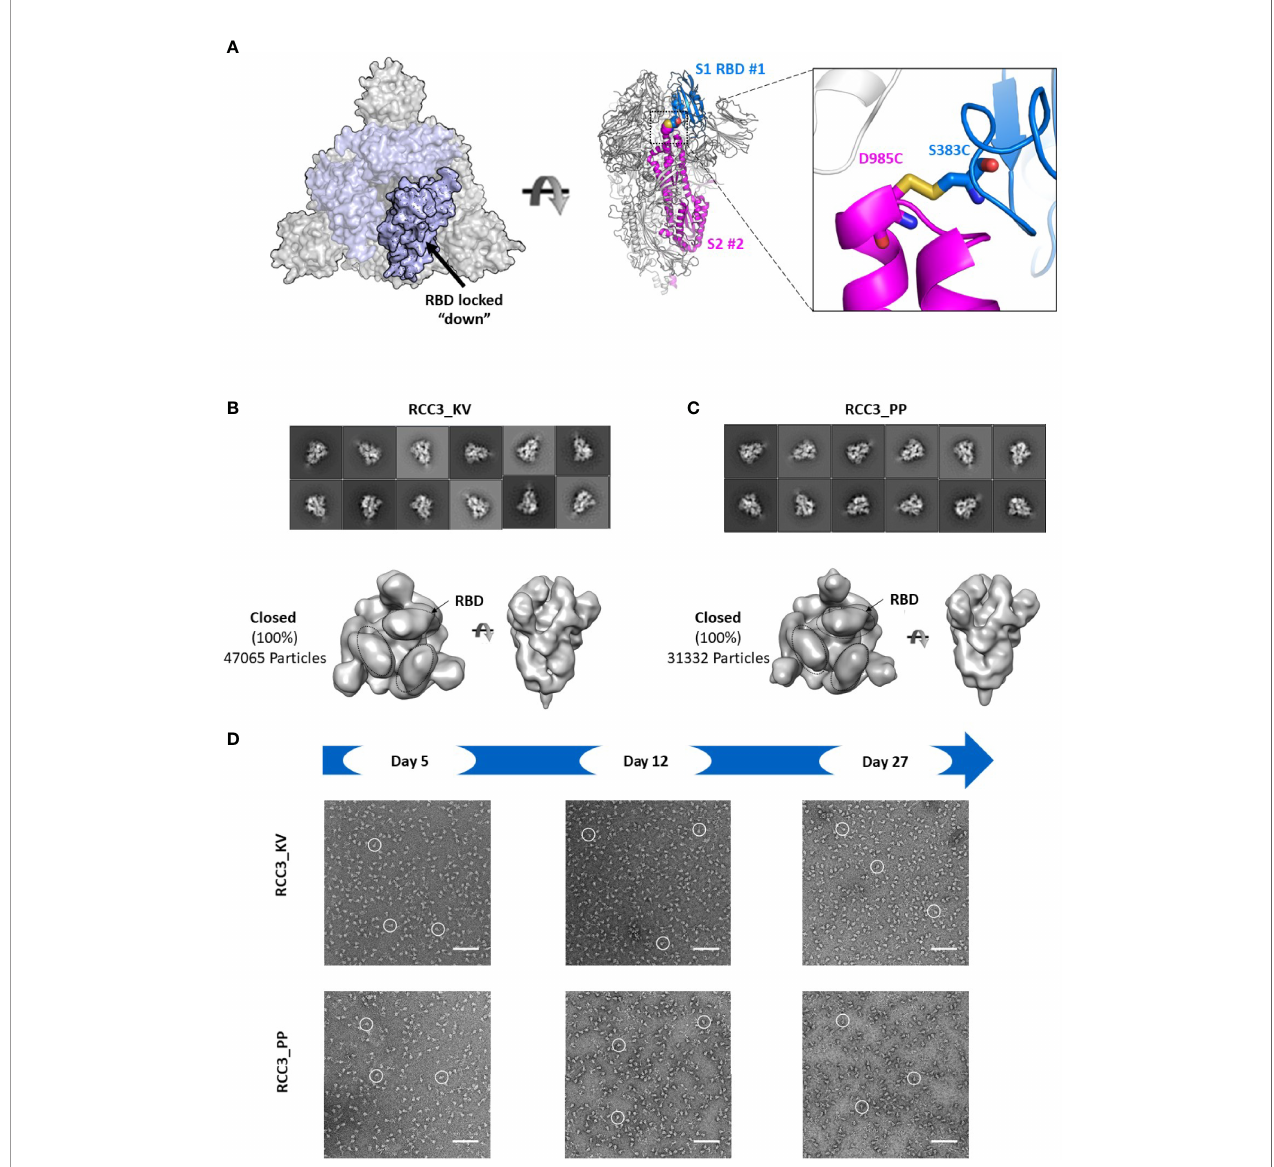
FIGURE 5 | RCC3 locks All RBDs into a singular orientation. Schematic representation of RCC3 disul fi de mutation expected RBD behavior (modeled from PDB 6VXX), viewed from the “ top ” (left) and “ side ” (center) and zoomed in to show the engineered disul fi de (right) (A) . 2D class averages (top) and 3D reconstruction (bottom) of negative stain EM images of the RCC3_KV (B) and RCC3_PP (C) designs demonstrate all particles contained all three RBDs in the “ closed ” con fi guration without disrupting the S2 subunit. Spike particles were observed by negative stain EM images to be stable without signi fi cant degradation up to 27 days (D) . Scale bars in (D) indicate 100nm and white circles highlight individual